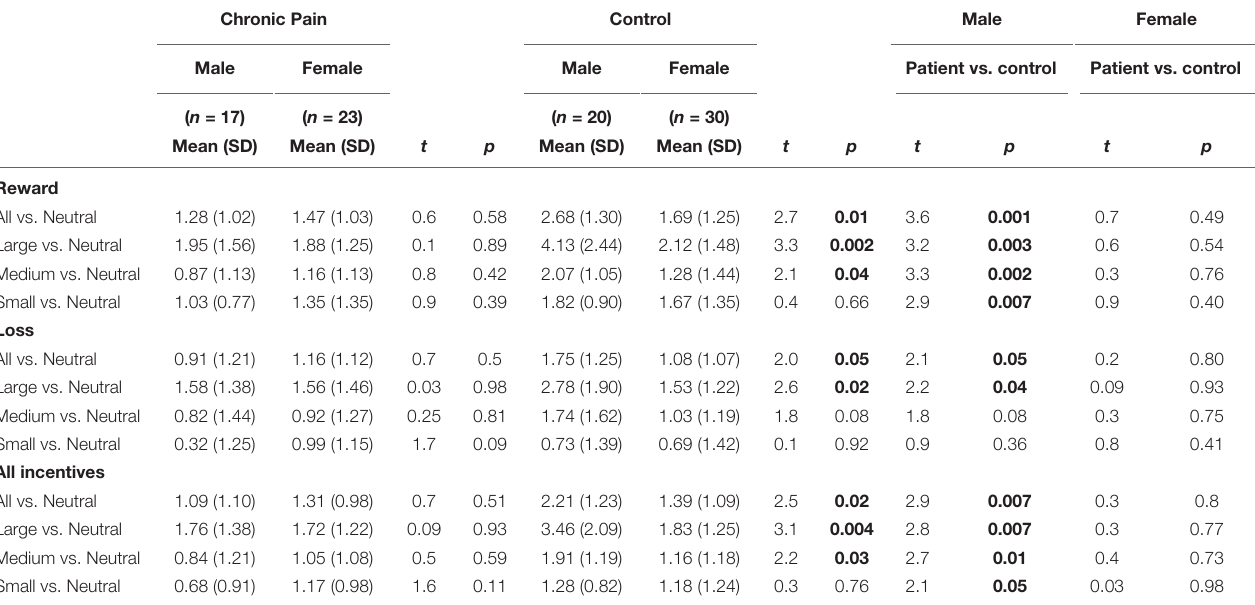
Mean ± 1 SD of changes in ventral striatal BOLD signal contrast averaged across right and left hemispheres during anticipation of monetary incentives. Reward, Trials of the monetary incentive delay task in which participants could earn or not earn money; Loss, Trials of the monetary incentive delay task in